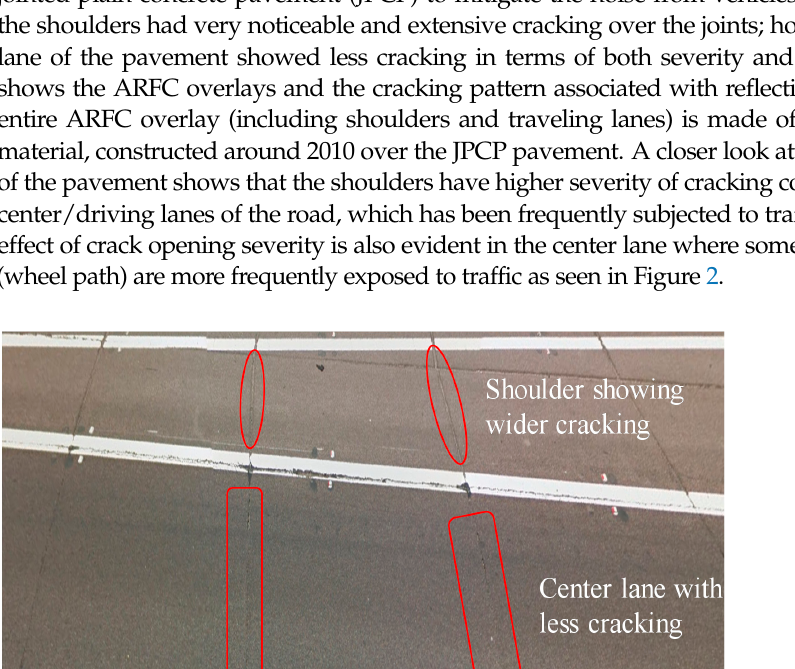
Figure 2. Severity of crack opening comparison in the driving lane between wheel path and non- wheel path (source: left photo Google map-highway 101, Tempe Arizona; right photo captured while driving on highway 202, Tempe, Arizona).